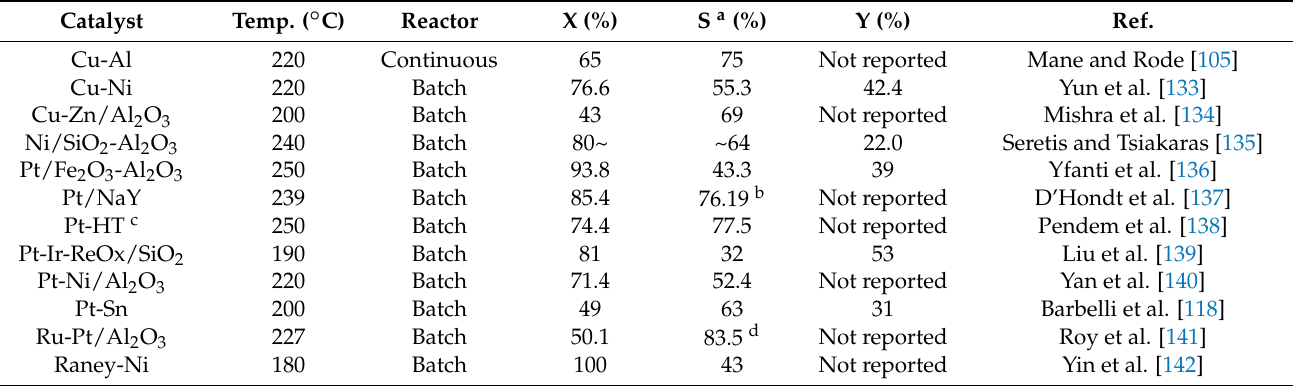
Table 4. Heterogeneous catalysts used for glycerol APR to